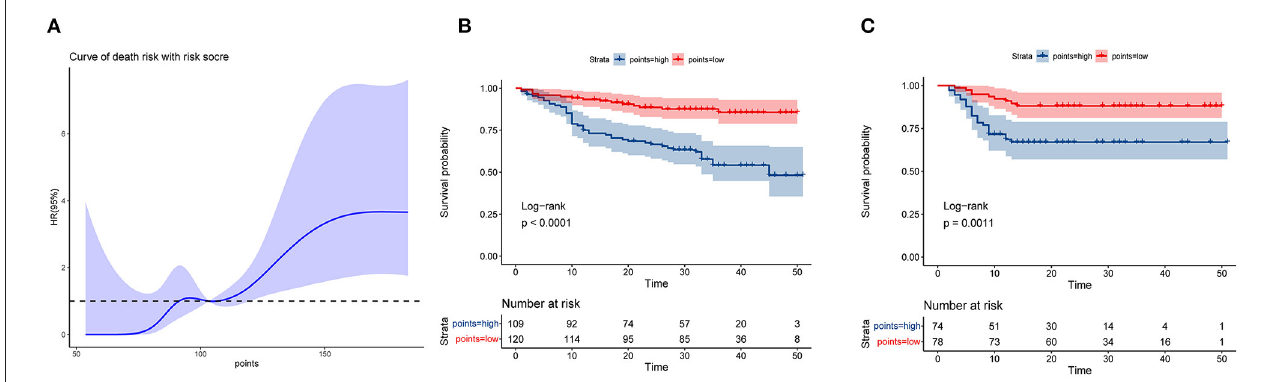
FIGURE 6 | Performance of the nomogram in stratifying the risk of patients. (A) Restricted cubic spline analysis of the total risk score in the training set. (B) Kaplan–Meier survival analysis between the low- and high-risk groups in the training set. (C) Kaplan–Meier survival analysis between the low- and high-risk groups in the validation